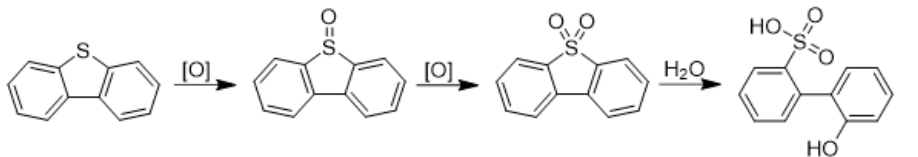
Figure 6. Proposed reaction pathway for the oxidation of dibenzothiophene (adapted with permission from ref [48]; published by ROYAL SOCIETY OF CHEMISTRY, 2003).